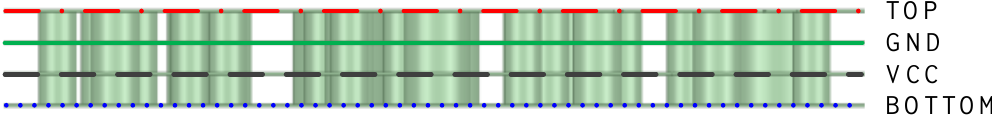
Figure 14. Acquisition card’s'printed circuit board (PCB) structure.